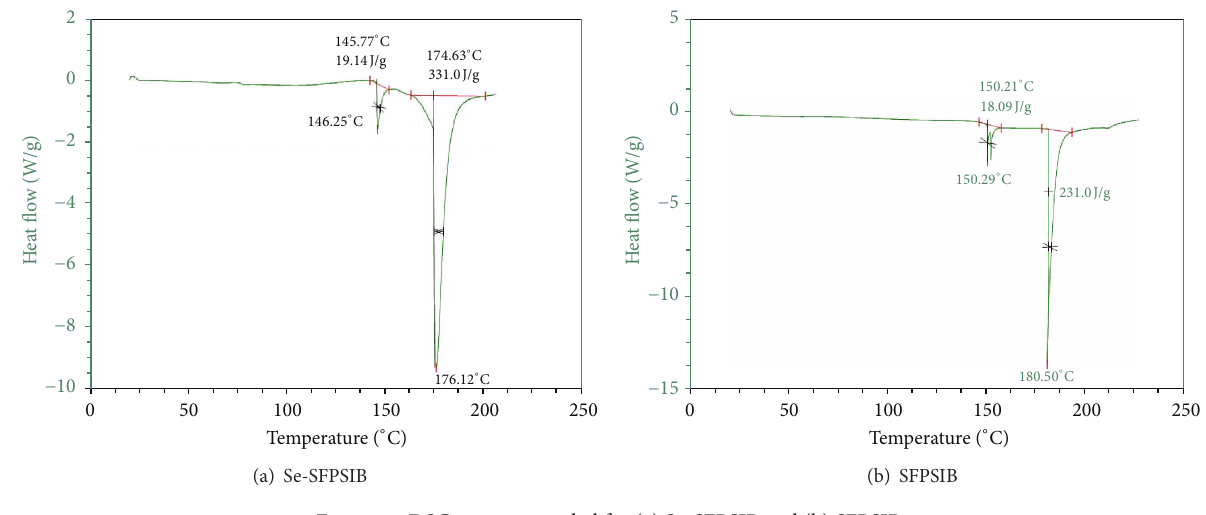
Figure 5: DSC curves recorded for (a) Se-SFPSIB and (b) SFPSIB.